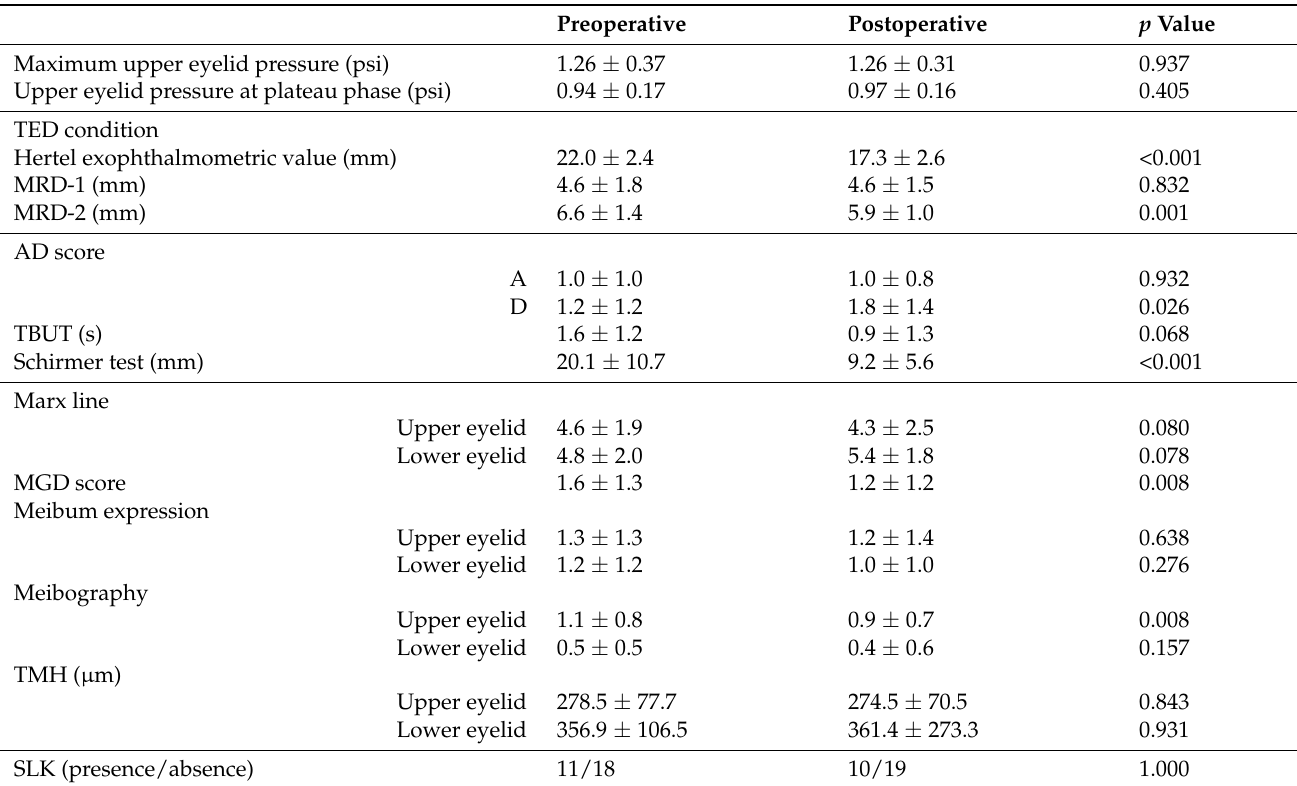
Table 2. The results of measurements and statistical comparison before and after orbital decompression. Preoperative